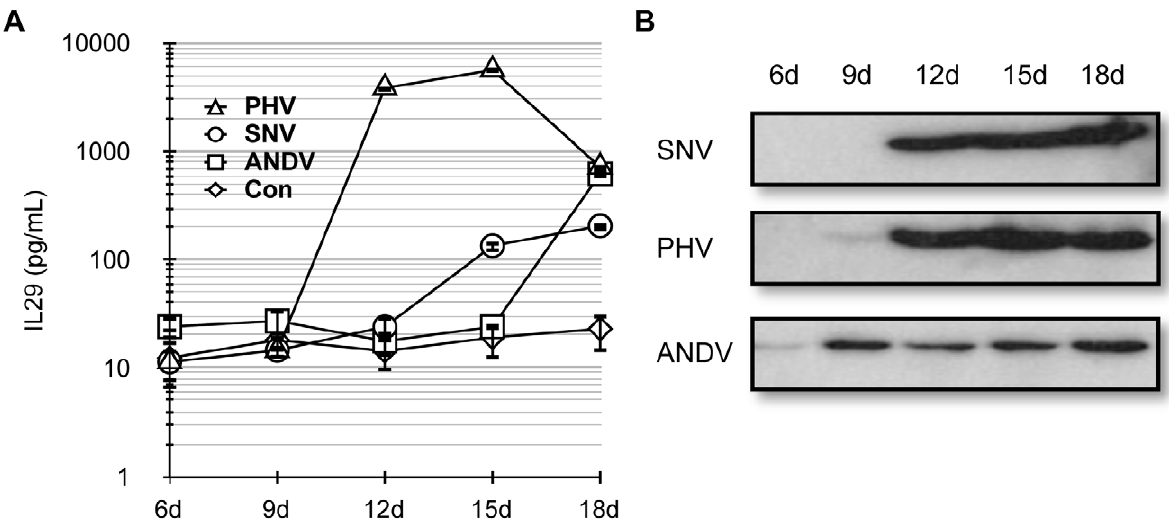
Figure 3. Divergent hantaviruses induce IFN l in Vero E6 cells independent of virus replication. Vero E6 cells were grown in 75 cm 2 culture flasks and infected with 10 3 ffu of PHV, SNV or ANDV for 1 h, or left untreated (Con). Supernatants were collected at the indicated time points post infection and total medium was replaced. (A) Equal volumes of supernatants were used in an ELISA to detect IL29. Error bars represent the standard deviation between duplicate ELISA experiments. (B) Equal volumes of supernatants were used for SDS-PAGE followed by western blotting. Membranes were probed with an anti-hantavirus N antibody.